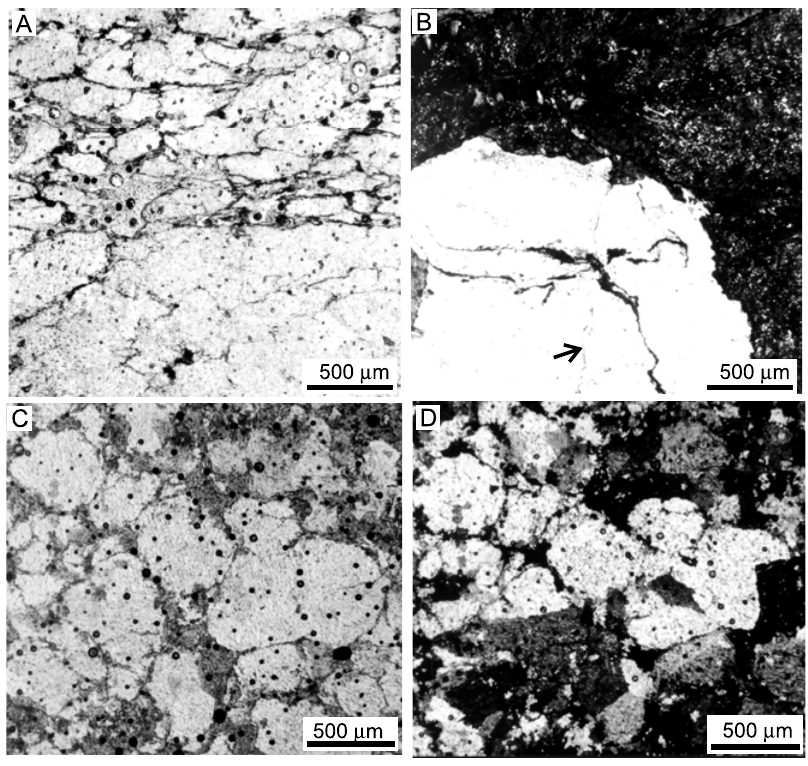
Fig. 7–TexturesoftheevaporitesfromtheCodóFormationexposedinthestudyareas. A)Brecciatedgypsum(upperpart)gradingfrom mosaic gypsum (lower part). The dark lines around the clasts in the upper part of the photograph were formed by a mixture of muds and iron oxides, probably resulting from mechanical infiltration (parallel polars). B) Detail of the brecciated gypsum, illustrating a crystal with several fractures (arrow). Note that the optical continuity beyond fracture boundaries, attesting that fracturing occurred within a single large crystal (crossed polars). C and D) Brecciated gypsum locally displaying well rounded clasts, resembling gypsarenite (C = parallel polars; D = crossed polars). Note in D that several clasts are in optical continuity, revealing they were most likely formed by fracturing of a same large